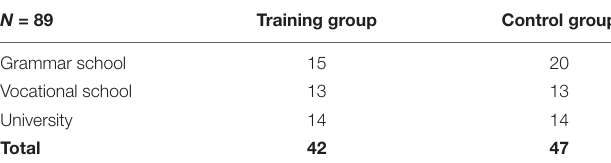
TABLE 1 | Distribution of the participants among groups and institutions. N = 89 Training group Control